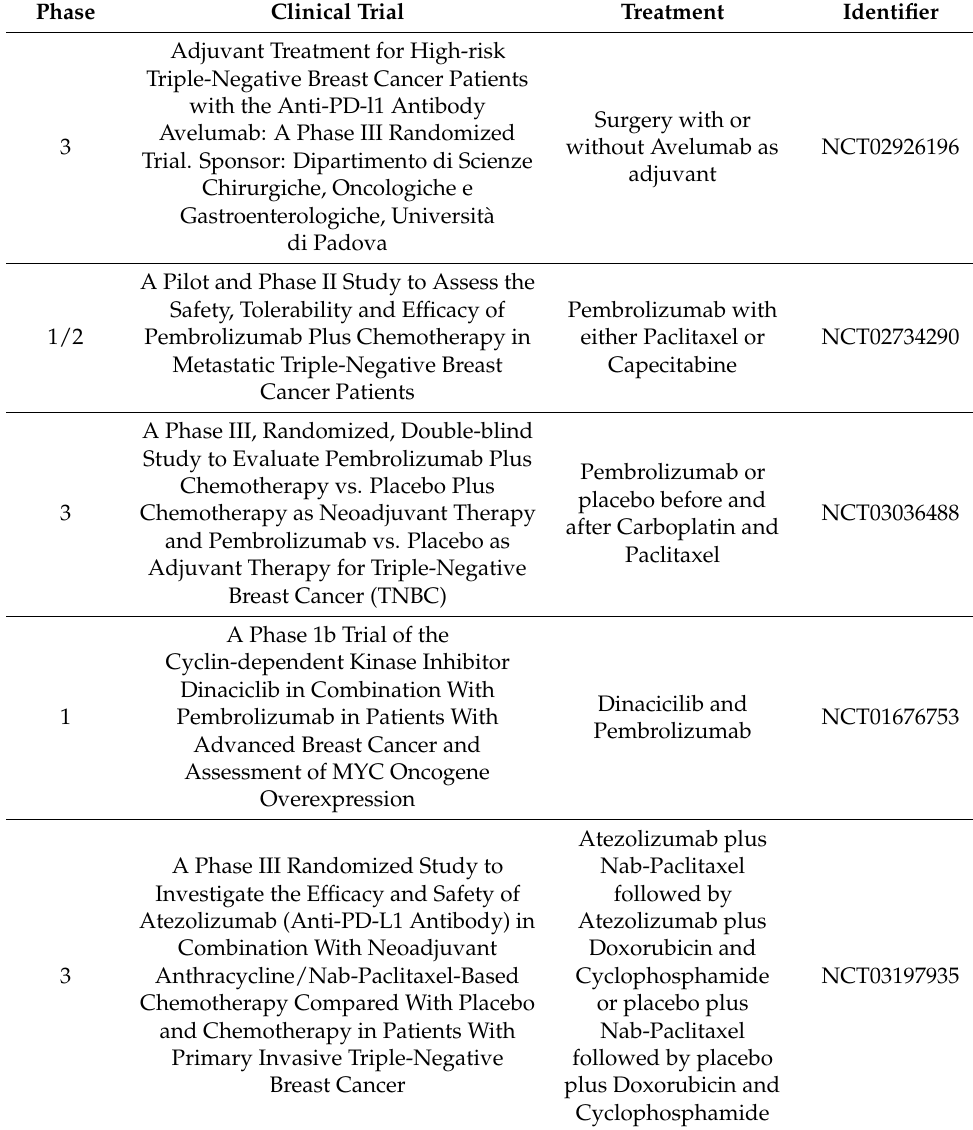
Table 5. List of active non-recruiting trials involving immunotherapeutic agents in